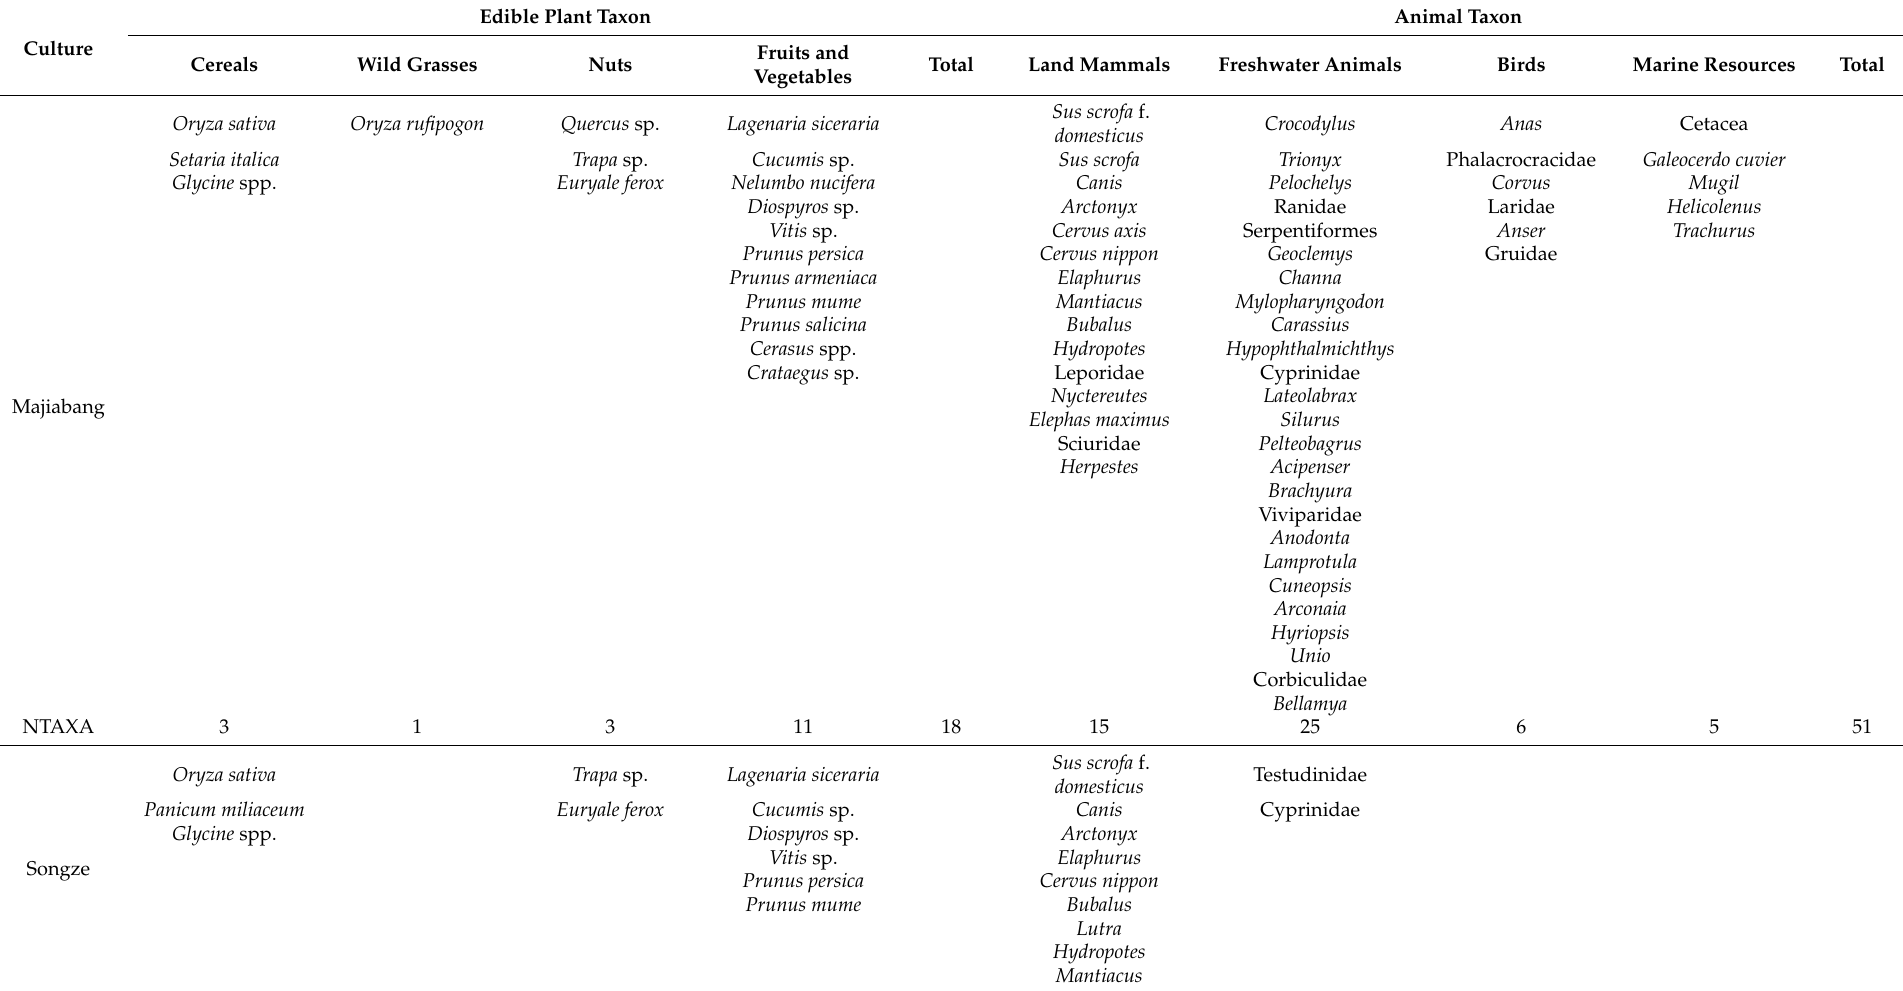
Table 2. List and NTAXA of plant and animal foods from archaeobotanical and zooarchaeological remains during each period of Neolithic in the area around Taihu